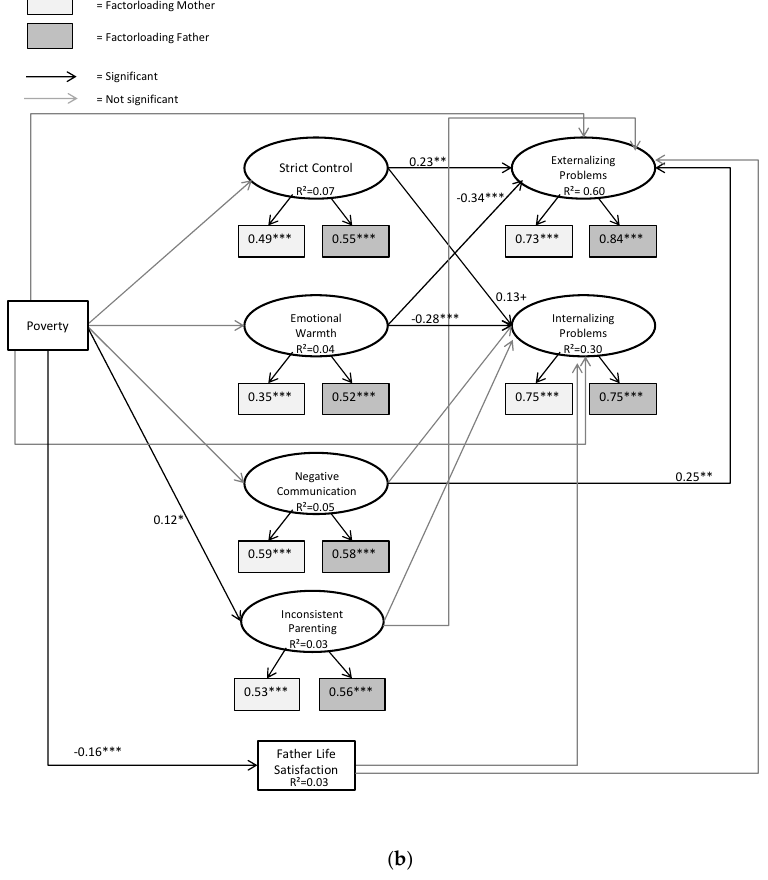
Figure 2. Poverty and child behavioral problems: ( a ) The mediating role of psychological control and mothers’ life satisfaction; ( b ) The mediating role of other parenting styles and fathers’ life satisfaction. Figure includes only significant mediators. N = 1097; control variables: sex, age (child and mother), migration background, number of children in the household, sample-region, and child care attendance. Model fit: chi ² = 357.407, df (125), p < 0.000, CFI 0.94, TLI 0.88, RMSEA 0.04, and SRMR 0.04. Tables including unstandardized coefficients, factor loadings, and residual covariances/correlations are available upon request. Levels of significance: *** p < 0.001, ** p < 0.01, * p < 0.05, + p < 0.1.